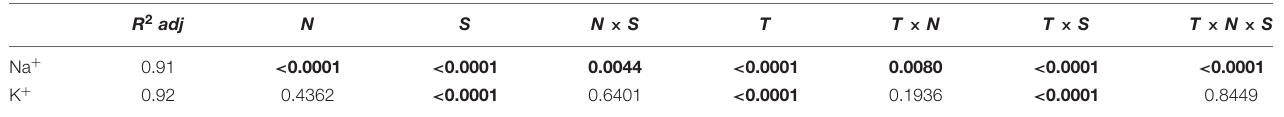
Values correspond to P values. Significant P values are highlighted in